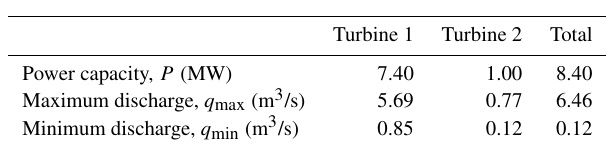
Table 1. Design characteristics of the two Francis-type